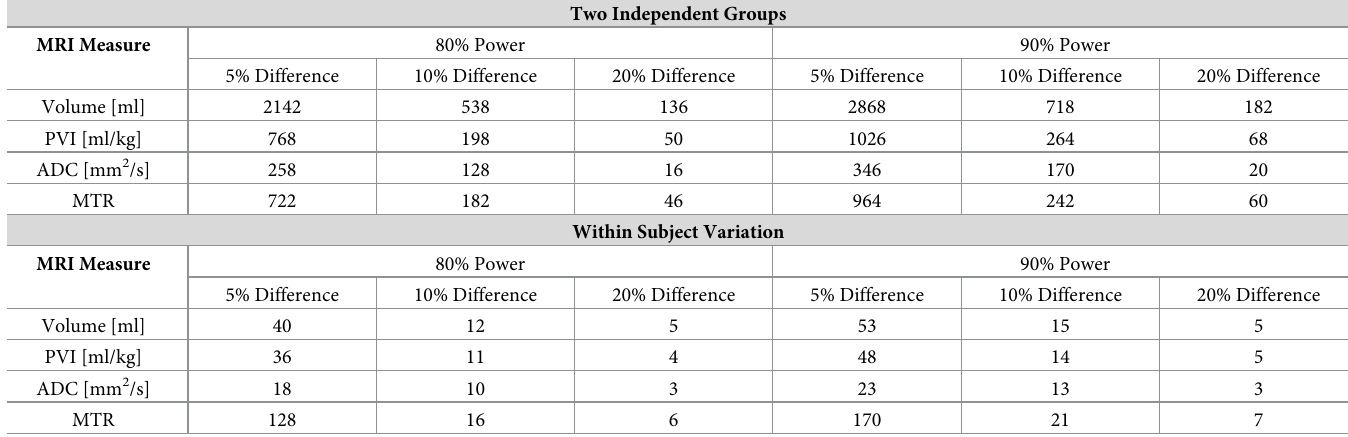
Table 4. Projected number of study participants required for future clinical trial (single